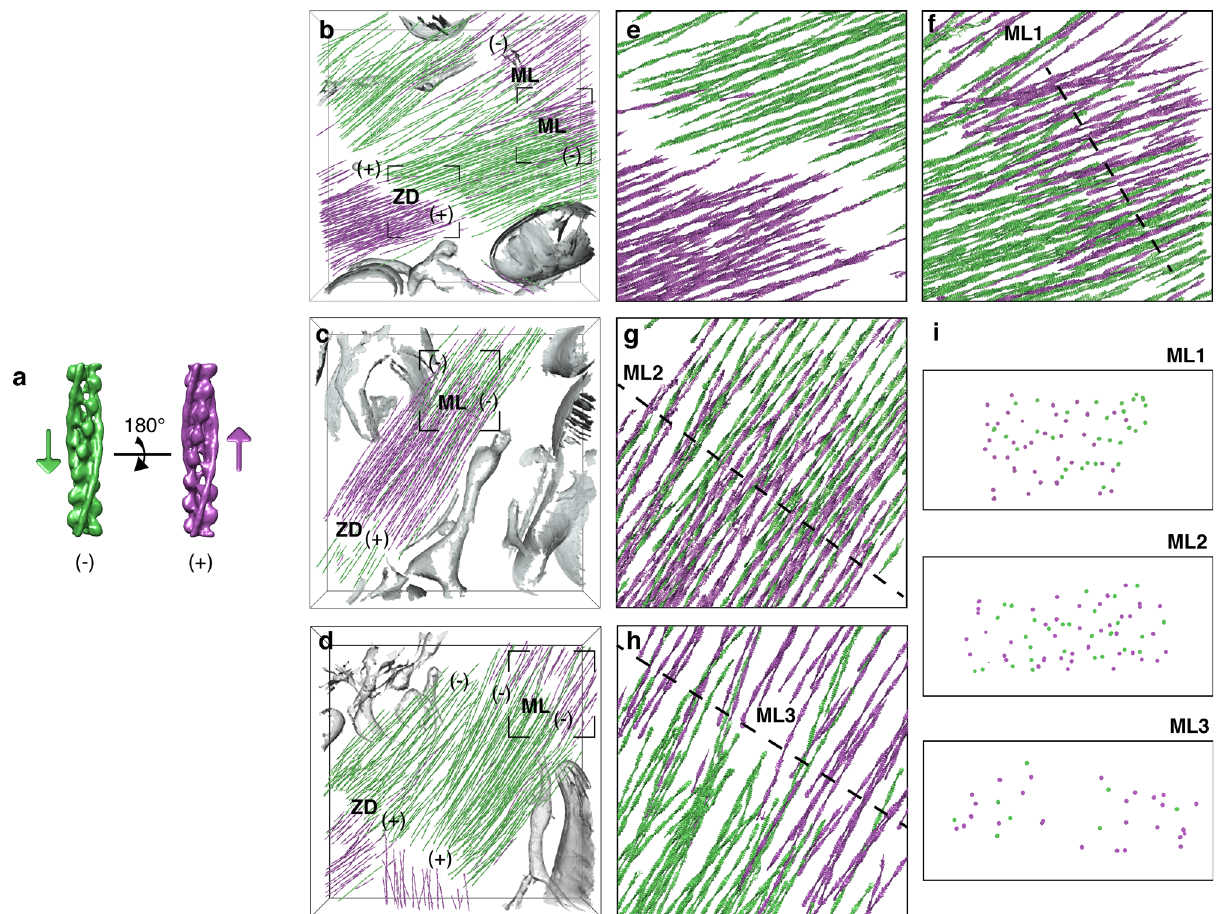
Fig. 4 Structural signature of sarcomere contraction. a De novo structures of the actin-Tpm fi lament in opposite orientations, represented by arrows pointing toward the pointed ( − ) end. b − d Polarity assignment for the neonatal cardiac thin fi laments shown in Fig. 2e, f and Supplementary Movie 2 ( b ; Supplementary Movie 3), Supplementary Fig. 3e, h ( c ; fi rst half of Supplementary Movie 4) and Supplementary Fig. 3f, i ( d ; second half of Supplementary Movie 4). Filaments are represented by arrows colored according to the assigned polarity. The gaps between thin fi laments facing each other with their barbed ends indicate the location of Z-disks (ZD). The overlap regions between thin fi laments of opposite polarity at the pointed ( − ) ends correspond to M-lines (ML). e , f Zoomed-in views of the framed regions in b showing the thin fi lament orientations at the Z-disk ( e ) and M-line ( f , ML1). g , h Zoomed-in views of the framed area in c , d , respectively, showing the thin fi lament orientations at the M-lines (ML2 − 3). i Cross-sections through ML1 − 3 at the locations indicated by the dotted lines in f − h . See Supplementary Fig. 8 for visualization of the unassigned fi